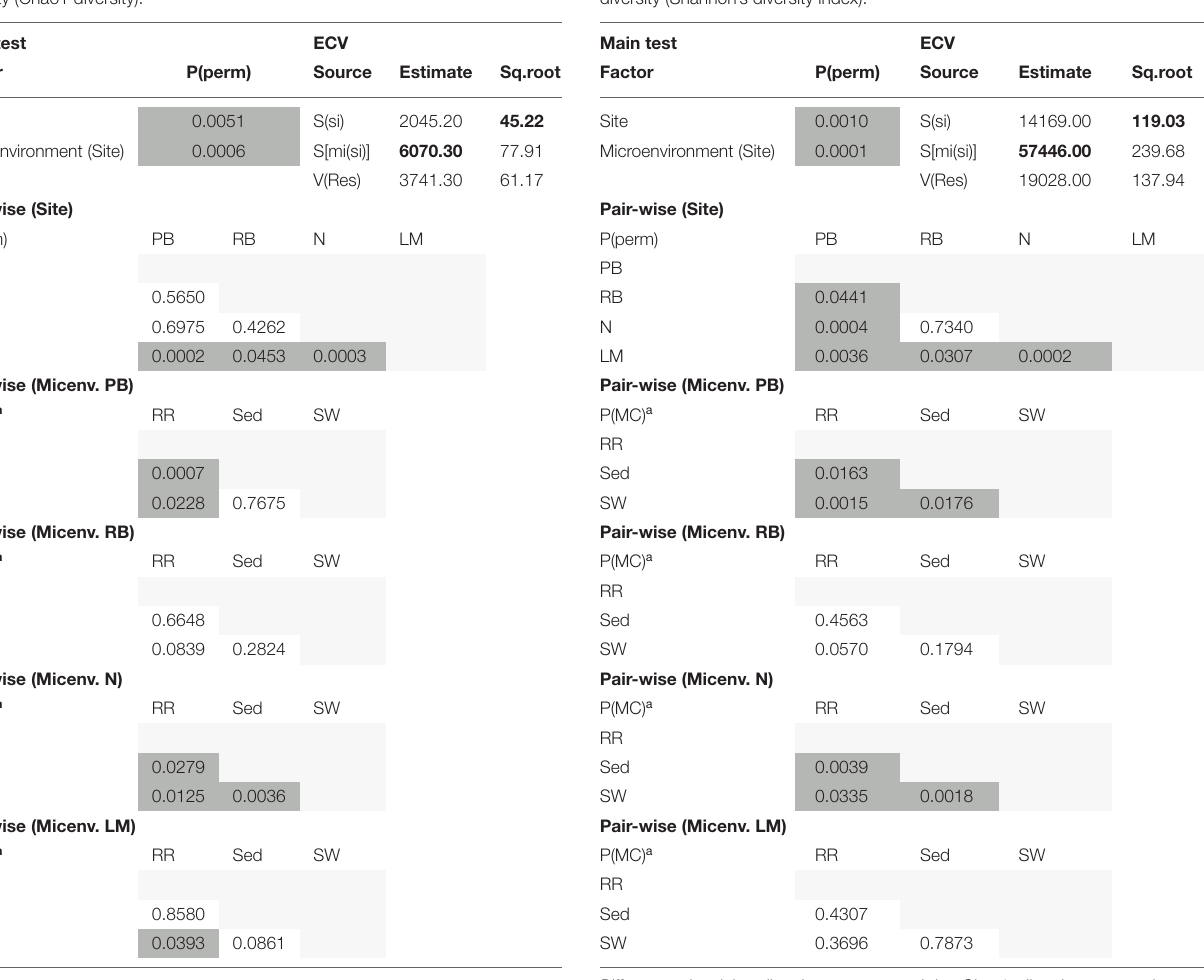
SUPPLEMENTARY TABLE 7 | Statistical analyses for bacterial mean alpha diversity (Shannon’s diversity index).